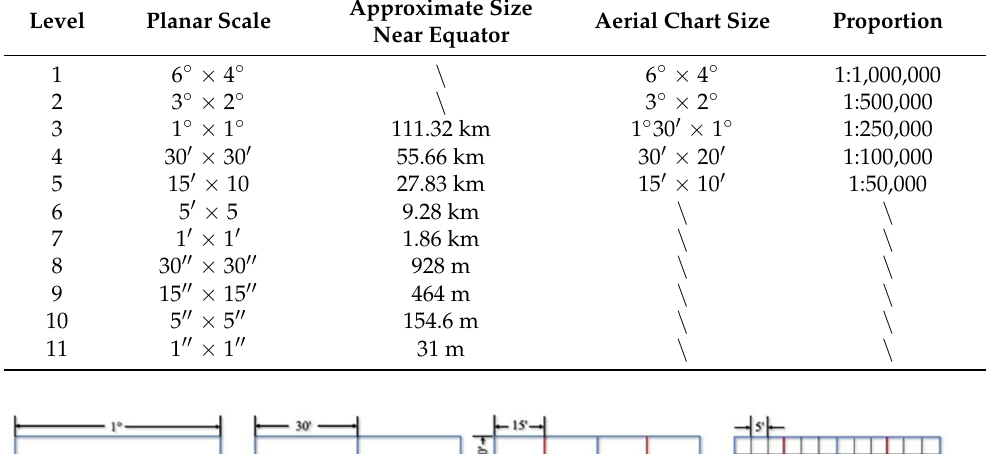
Based on the above constraints and correspondences, the following airspace planar dimensional discretization was designed, with the basic discretization architecture shown in Figure 3. The origin of the Earth’s surface airspace 2D grid is at the intersection of the equator and the prime meridian. The Earth’s surface 2D grid is divided into 11 levels ac ‐ cording to the following division method: